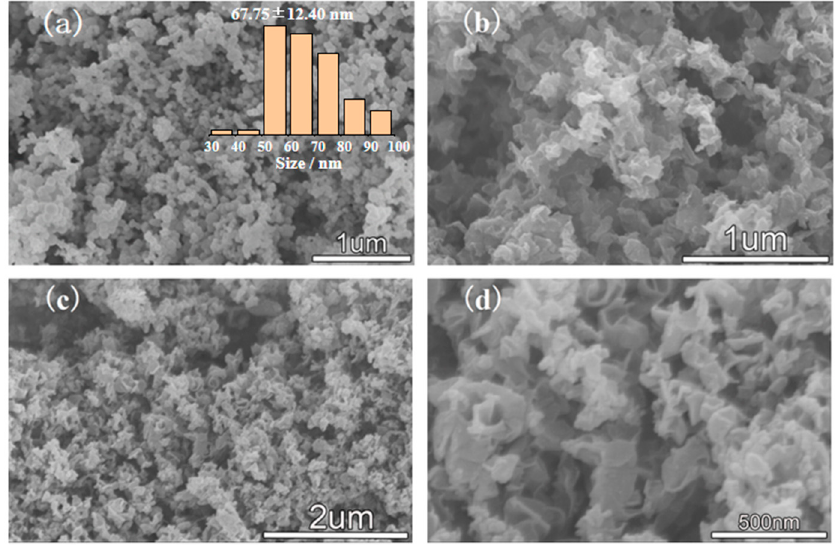
Figure 5. SEM images of the pure Si nanoparticles ( a ), pure tremelliform carbon nanosheets ( b ), silicon-carbon nanocomposite ( c , d ) prepared by DC magnetoelectric plasma under optimal conditions. Inset: size distribution of the Si nanoparticles.